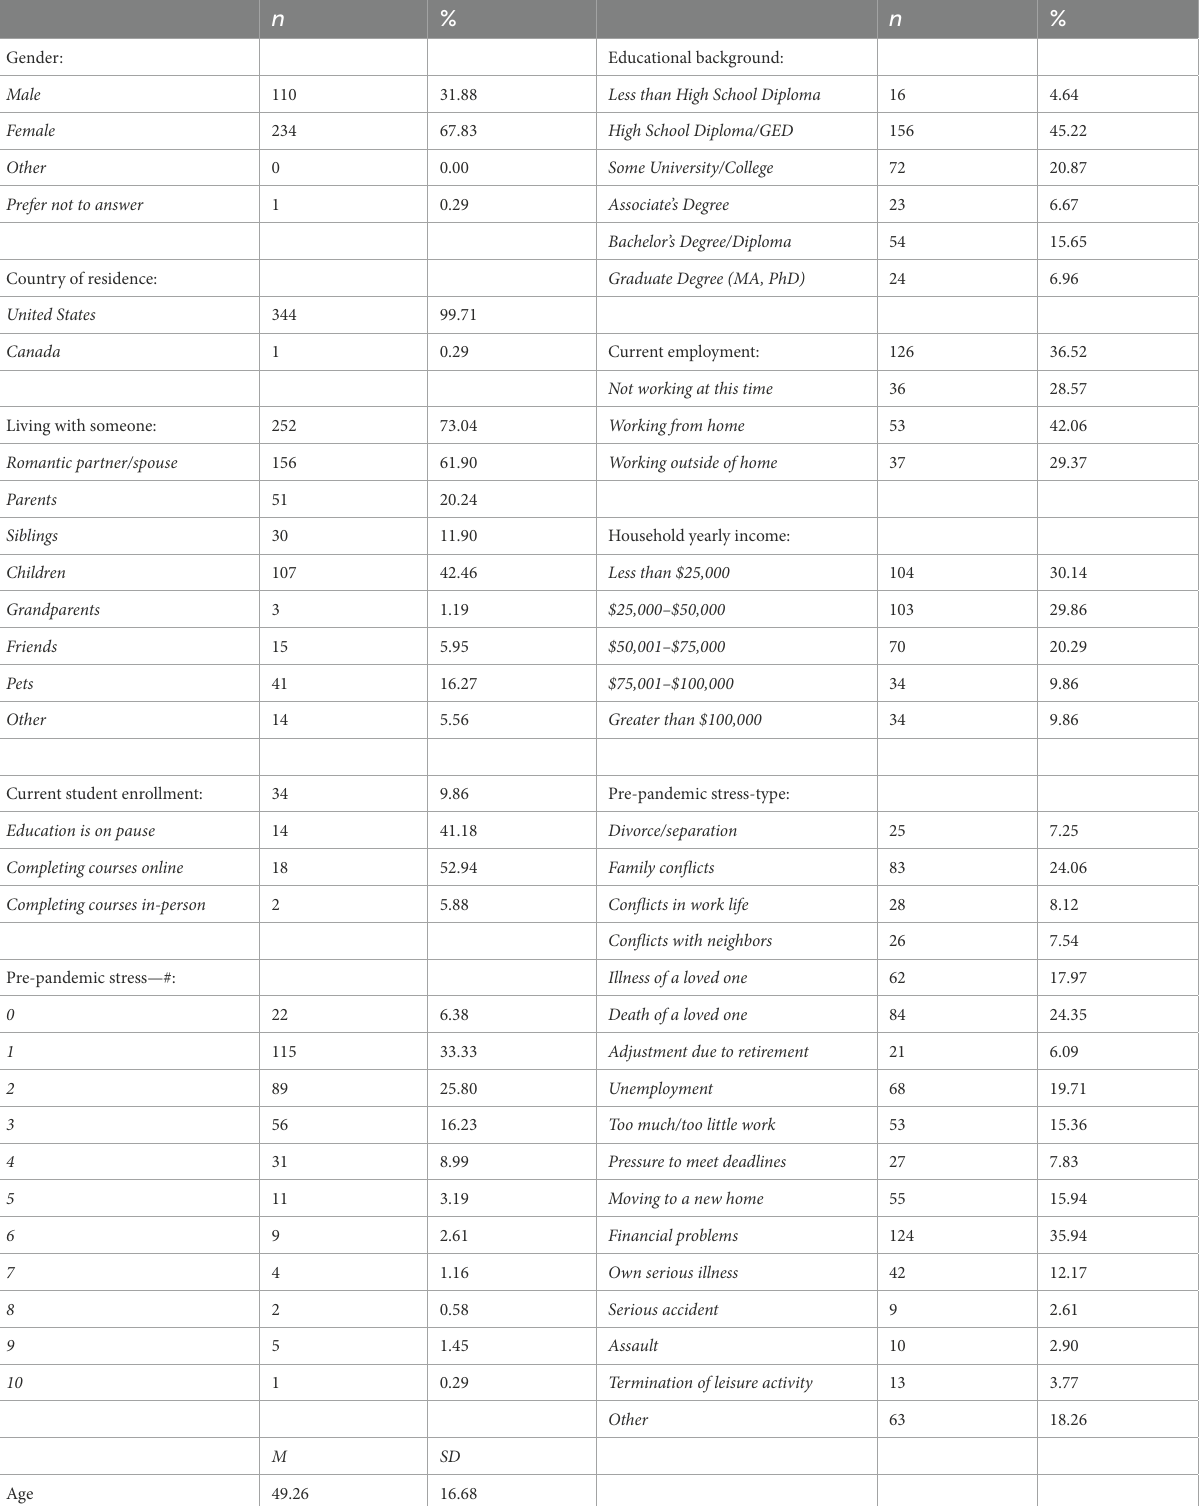
TABLE 1 Sample characteristics ( N =